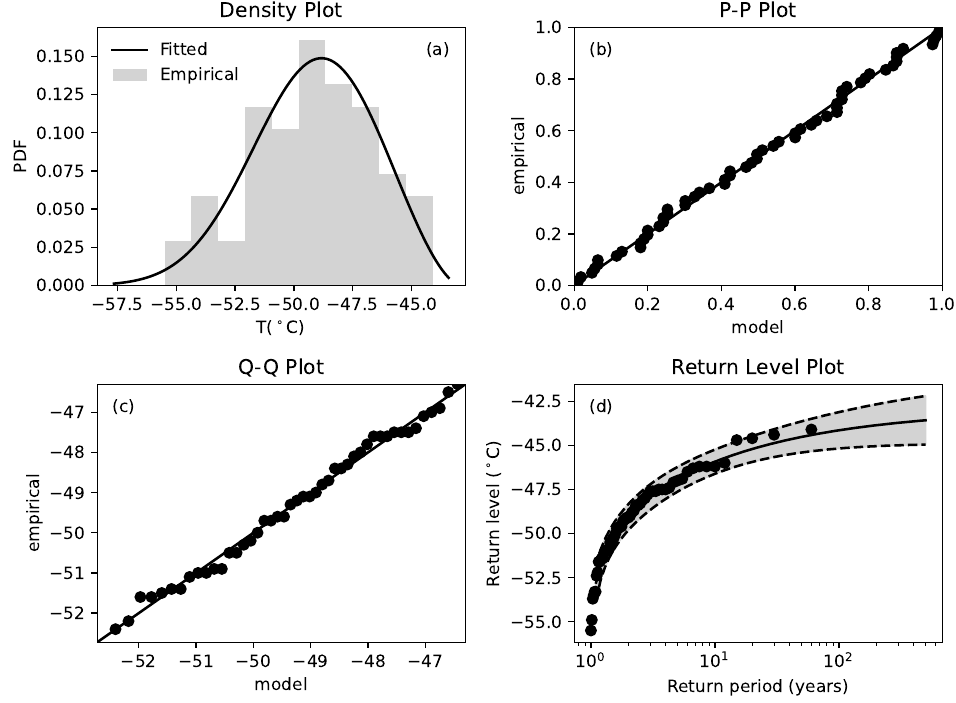
Figure 4. ( a ) Density plot, ( b ) probability plot, ( c ) quantile plot, ( d ) return level plot for the annual minimum temperature values at Halley